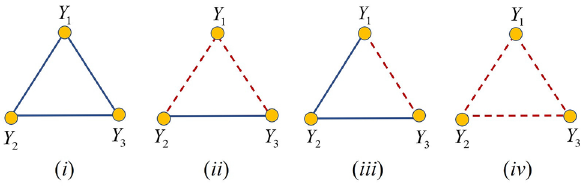
Figure 1. Graphical representation of the interdependencies between stocks Y 1 , Y 2 and Y 3 in a triad. Stocks are represented as the vertices of a triangle and edges represent the correlation between them as accounted for by Kendall’s tau. Positive are represented as solid (blue) lines between the corresponding stocks, and negative are represented as dashed (red)